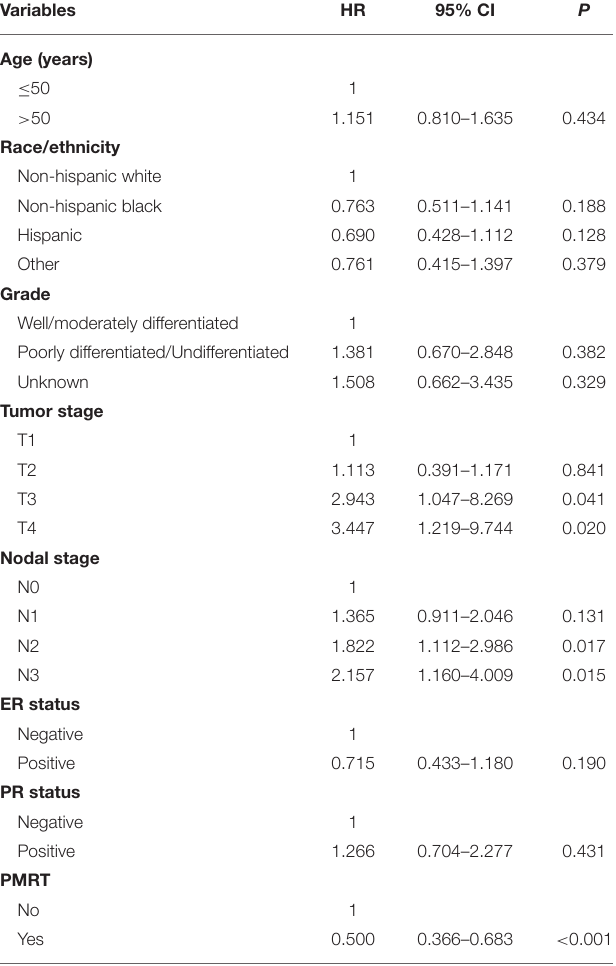
TABLE 3 | Multivariate analysis of prognostic factors in breast cancer specific survival.